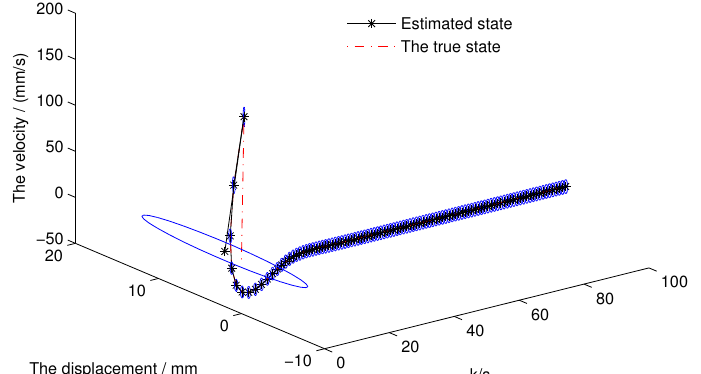
Figure 10. The estimated states and the evolution of the system states feasible sets for the pro- posed